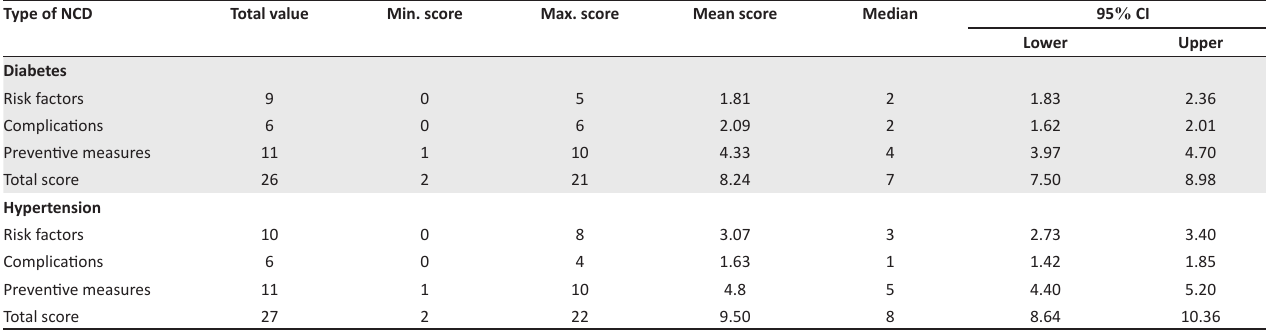
TABLE 3: Community health workers knowledge scores of diabetes and hypertension. Type of NCD